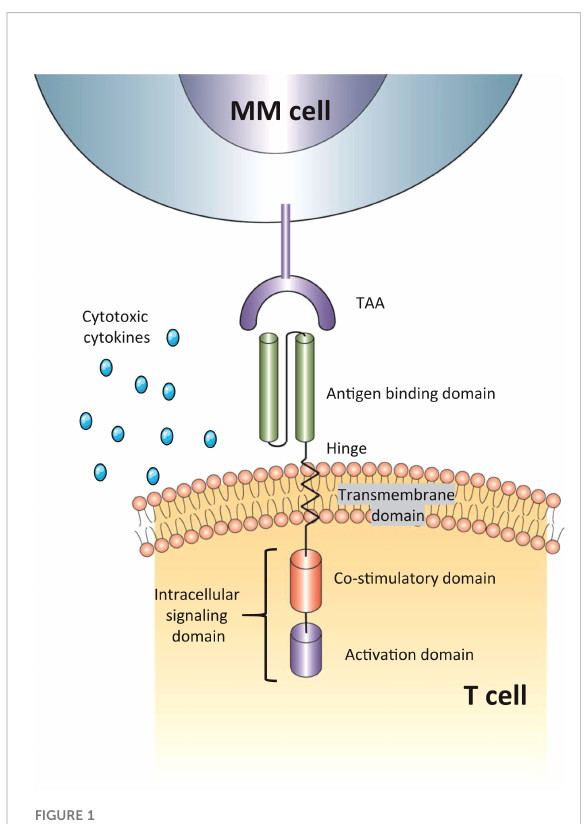
FIGURE 1 The structure of CAR-T cells. The antigen-binding domain is usually a single-chain variable fragment (scFv) but also has other structures; intracellular signaling domain include both co- stimulatory domain (CD28, 4-1BB) and activation domain (CD3zeta). TAA, tumor-associated antigen; MM cell, multiple myeloma